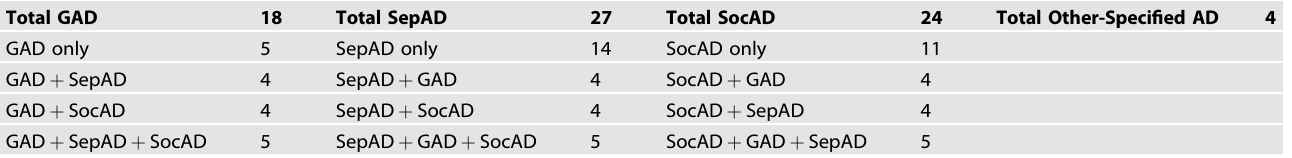
Table 1. Distribution of AD Cohort ( n = 51) by Diagnoses.